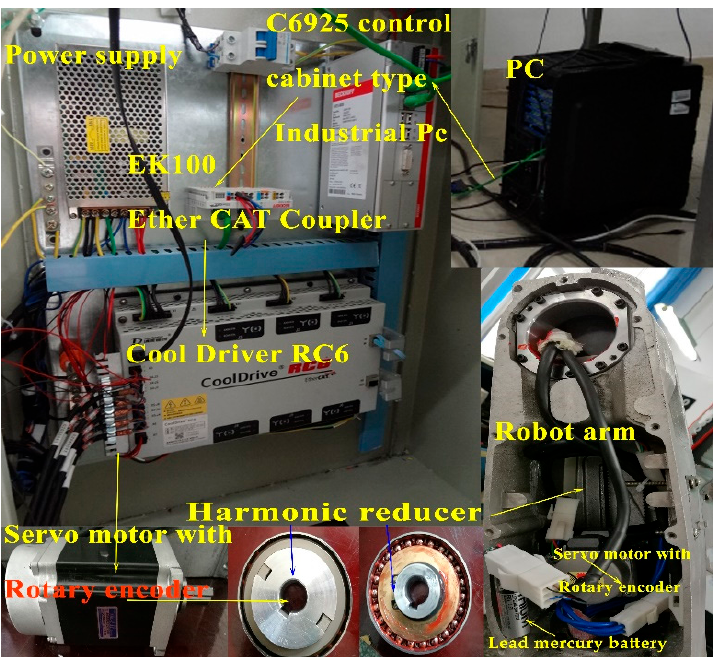
Figure 11. The Signal flow graph for the system of the overall structure in this experiment.